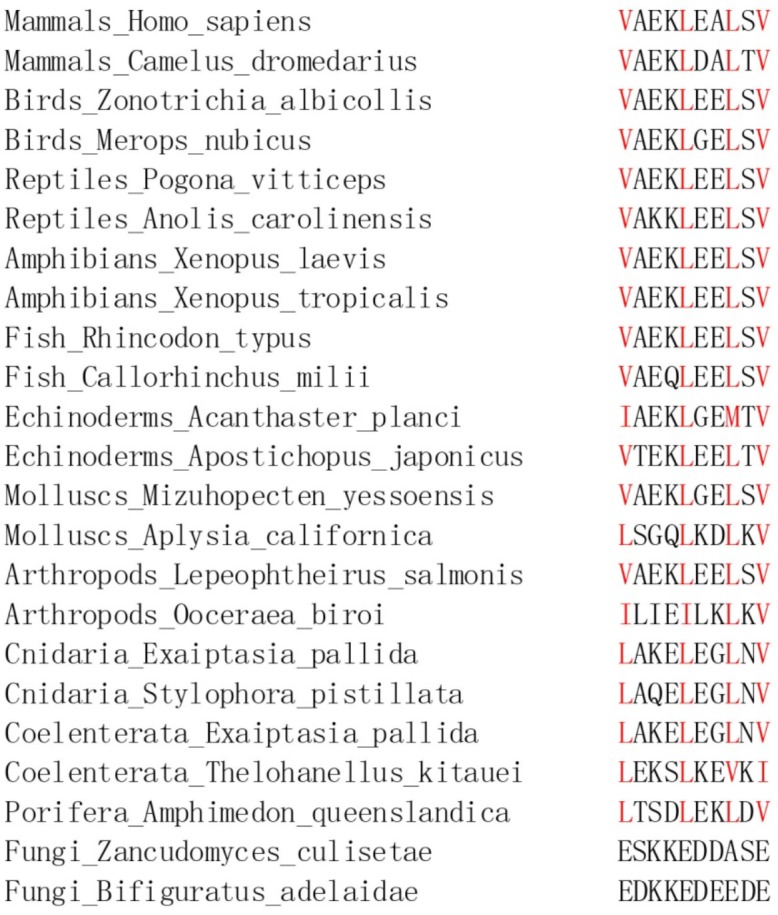
NES of RanBP1 is conserved in animals but does not exist in fungi.hRanBP1 is blasted against different domain or phylums using BLASTp. The NES in the most and the least conserved RanBP1 from each domain or phylum are shown. Only one RanBP1 sequence is available in PubMed for Porifera phylum and RanBP1 is not found for a couple of phyla. Letters in red highlight hydrophobic residues that constitute the NES.